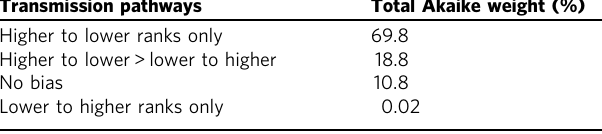
Table 3 NBDA aim 2: identifying the typical pathway of social transmission. Transmission pathways Total Akaike weight (%) Higher to lower ranks only 69.8 Higher to lower > lower to higher 18.8 No bias 10.8 Lower to higher ranks only